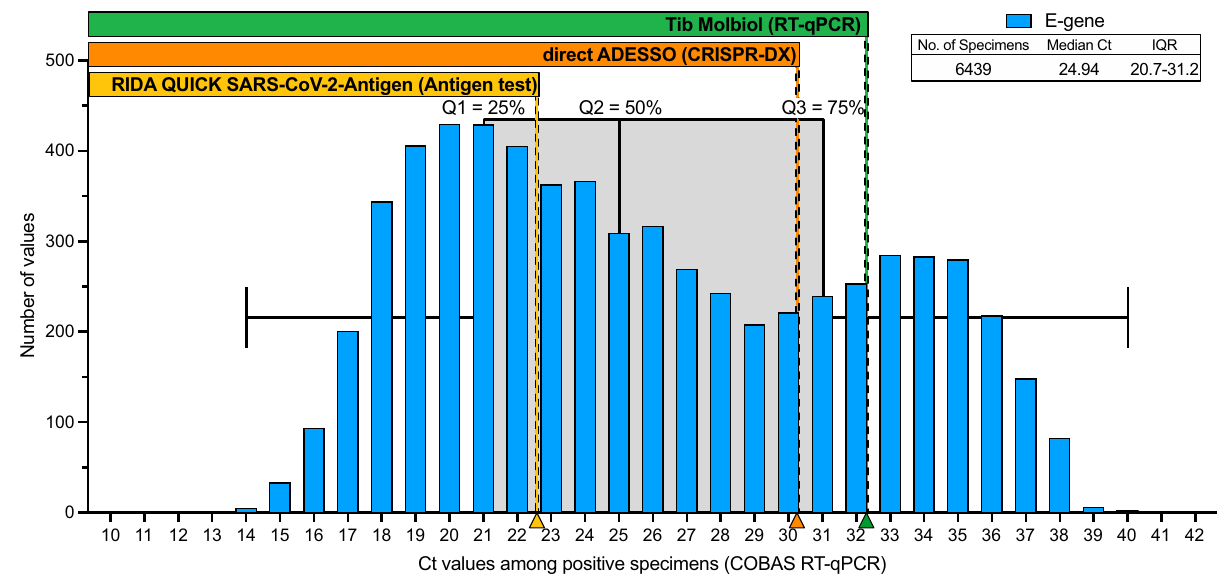
Fig. 4 Ct value distribution across a population of non- or mildly symptomatic COVID-19 positive individuals. The histogram shows the distribution of Ct values detected by using COBAS RT-qPCR (SARS-CoV-2 E gene) across 6,439 positive samples. These were collected from ambulatory patients showing minimal to mild symptoms. The box plot of these Ct values is represented in grey. Center line denotes the median (Ct = 24.94), bounds denote IQR (20.7 – 31.2) and whiskers denote minimum (13.73) and maximum (40.05). Quartiles (Q) 1, 2, 3 are also indicated to highlight the 25, 50, and 75% portions of the population, respectively. Arrowheads on the x axis represent the Ct values corresponding to the LoD of the three different detection methods, as evaluated in this work (Fig. 2). The rectangles above the histogram indicate the range of Ct values and the portions of specimens that would be detected by the three tests compared in this study (antigen test in yellow, direct ADESSO in orange and RT-qPCR in green).